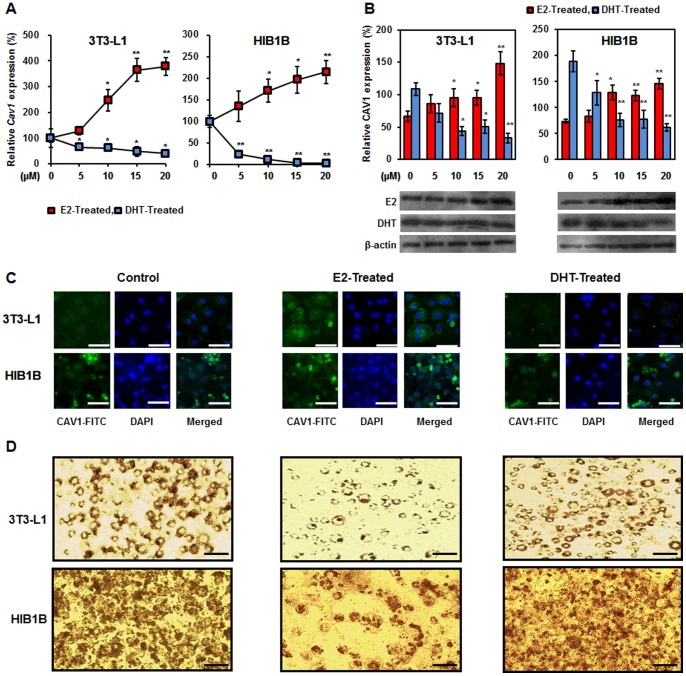
Effects of sex hormone treatments on Cav1 expression in 3T3-L1 and HIB1B adipocytes (A), CAV1 protein expression levels (B), CAV1 expression levels by immunocytochemistry (C), and fat accumulation as determined by Oil Red O staining (D).Scale bar represents 50 µM and 25 µM, respectively. Statistical significance between different groups was calculated by Student’s t-test, where *p<0.05 and **p<0.01.